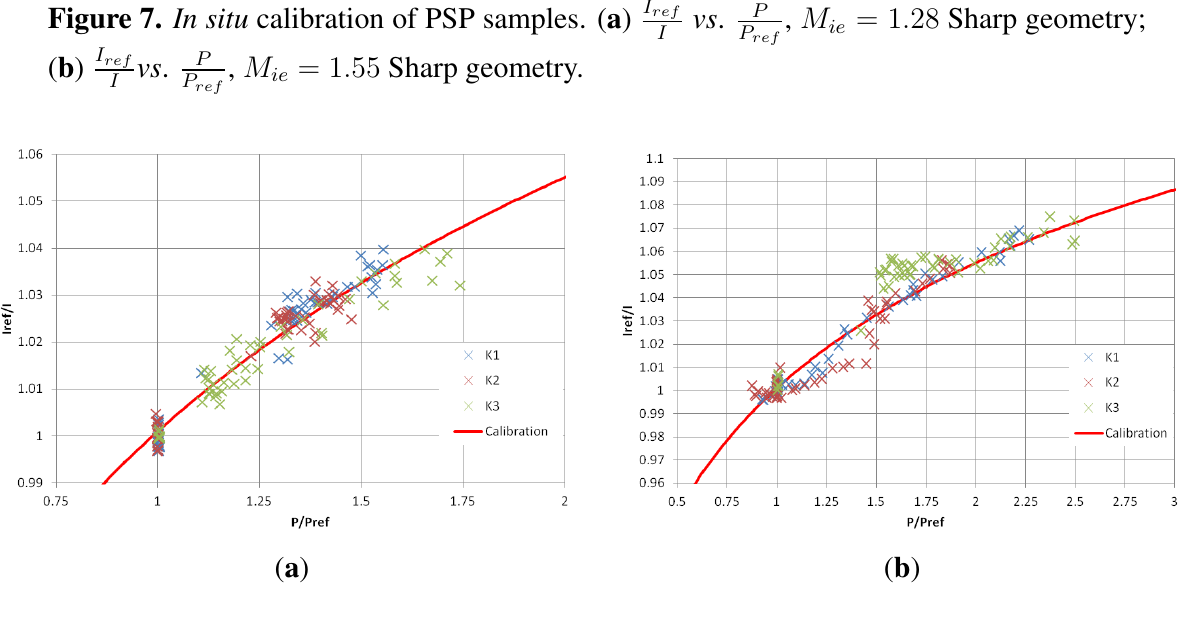
vs . P , M = 1 . 28 Sharp geometry; ie I P ref